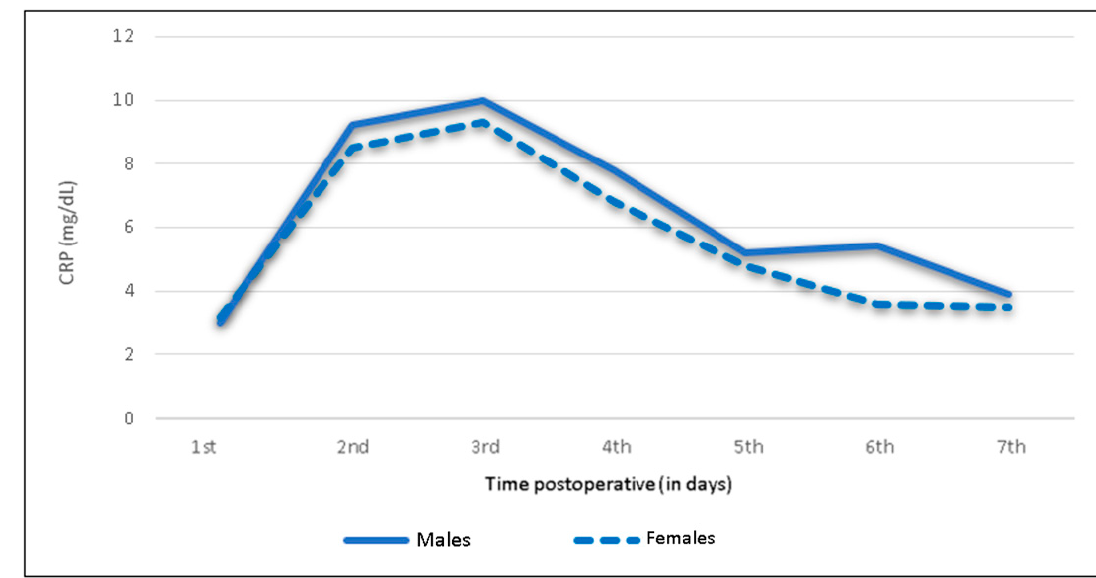
Figure 3. Sex-specific mean C-reactive protein levels and trend following shoulder arthroplasty.